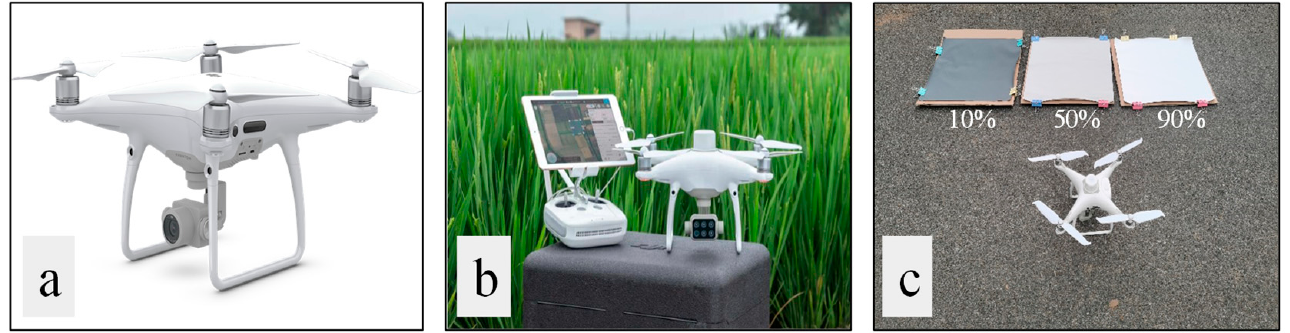
Figure 2. ( a ) UAS with digital camera for V images, ( b ) UAS with multispectral camera for V-NIR images, and ( c ) diffuse reflective